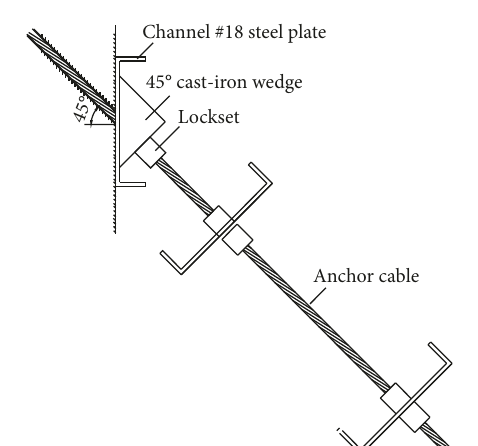
Figure 16: Structure diagram of the self-locking anchor